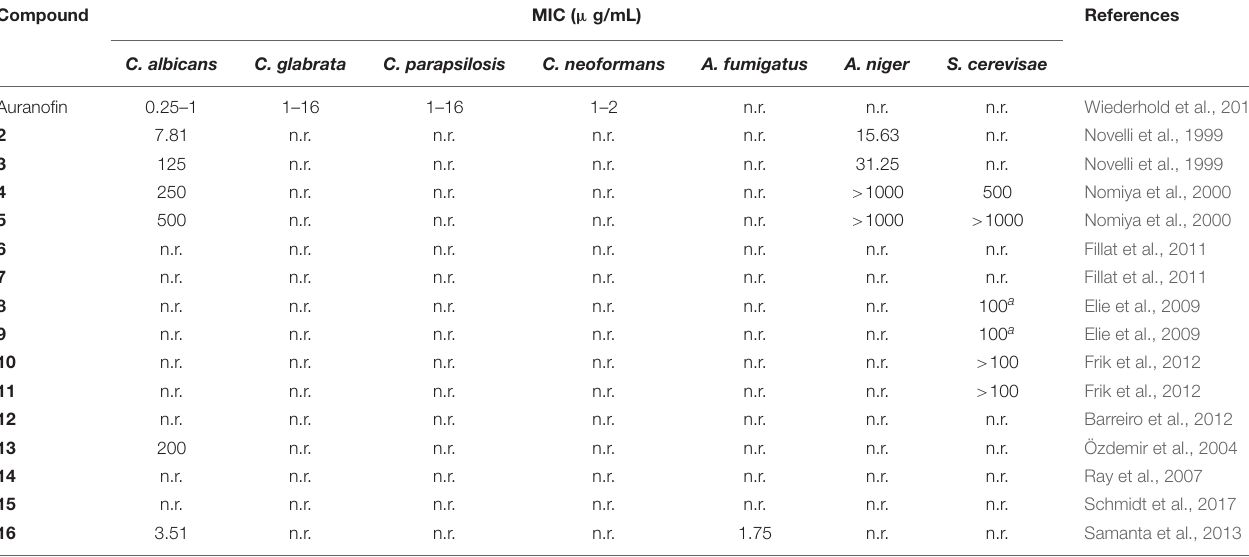
TABLE 2 | Antifungal activity (MIC) of the gold(I) complexes.